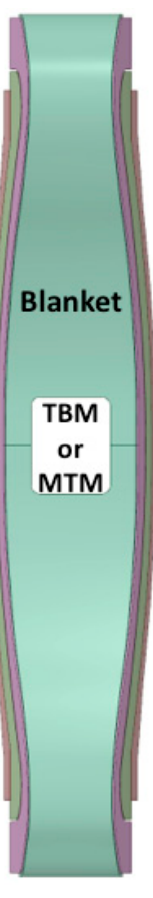
Figure 3. Test Blanket Module (TBM) or Materials Testing Module (MTM) integrated with the outboard sector of the Fusion Nuclear Science Facility.